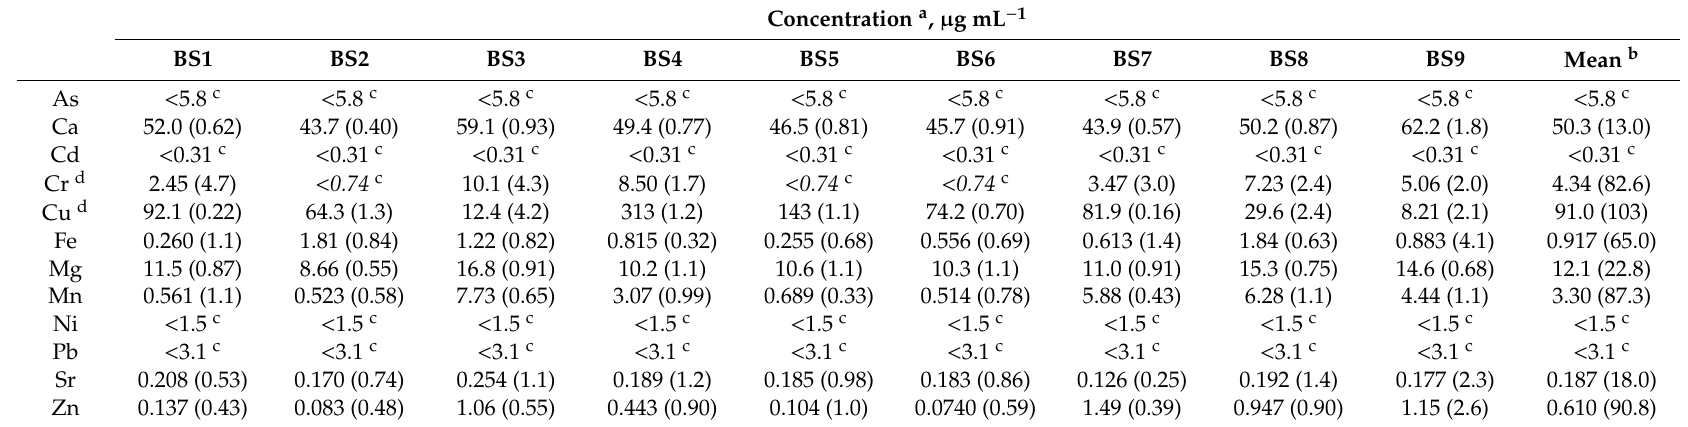
Table 5. Results of multi-element analysis of di ff erent birch saps (BS1–BS9) by ICP OES with no sample